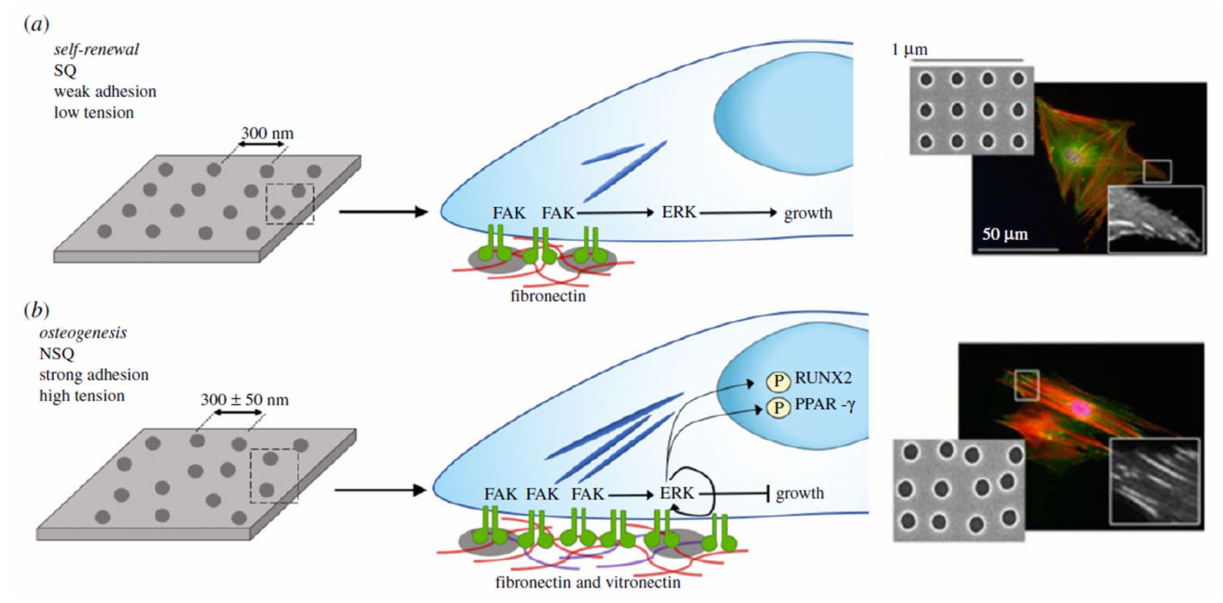
Figure 4. Controlling MSC adhesion for osteogenesis and self-renewal by topography. ( a ) Self-renewing MSCs bind weakly compared to osteo-committed cells, leading to a reduction of integrin-mediated signaling via focal adhesion kinase (FAK), while retaining levels of extracellular signal-regulated kinase (ERK1/2) to promote growth but not separation. ( b ) MSCs inducing osteogenesis need greater adhesions: enhanced FAK activation raises ERK1/2 activation to lineage commitment levels, raising intracellular stress, activating Runt-related transcription factor 2 (RUNX2), a central regulator of osteogenesis, although subsequently inactivating adipogenic controller peroxisome proliferator-activated receptor gamma (PPAR-y). Fluorescent photographs display a significant improvement in adhesion length on near square (NSQ) surfaces relative to square (SQ). Adjusted from the source